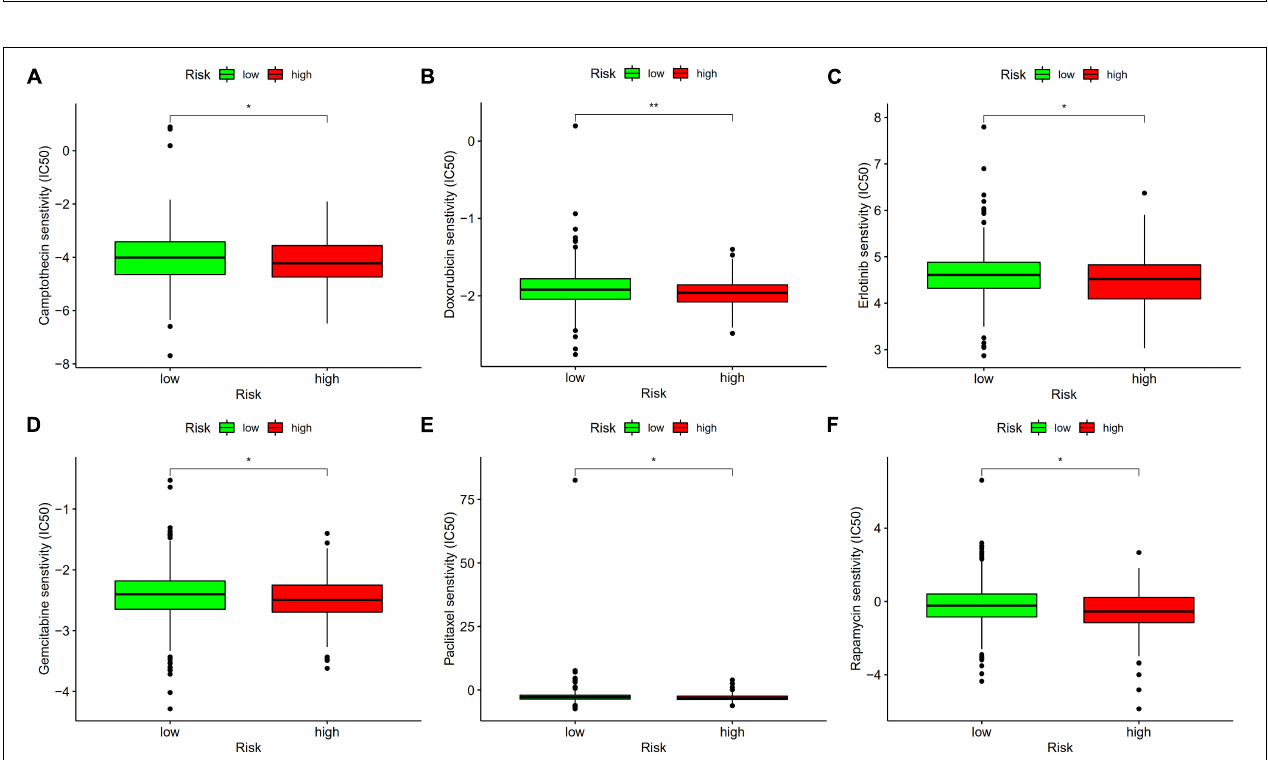
FIGURE 10 | Lower IC50 of camptothecin (A) , doxorubicin (B) , erlotinib (C) , gemcitabine (D) , paclitaxel (E) , and rapamycin (F) were associated with a higher risk score. * p < 0.05; ** p < 0.01.